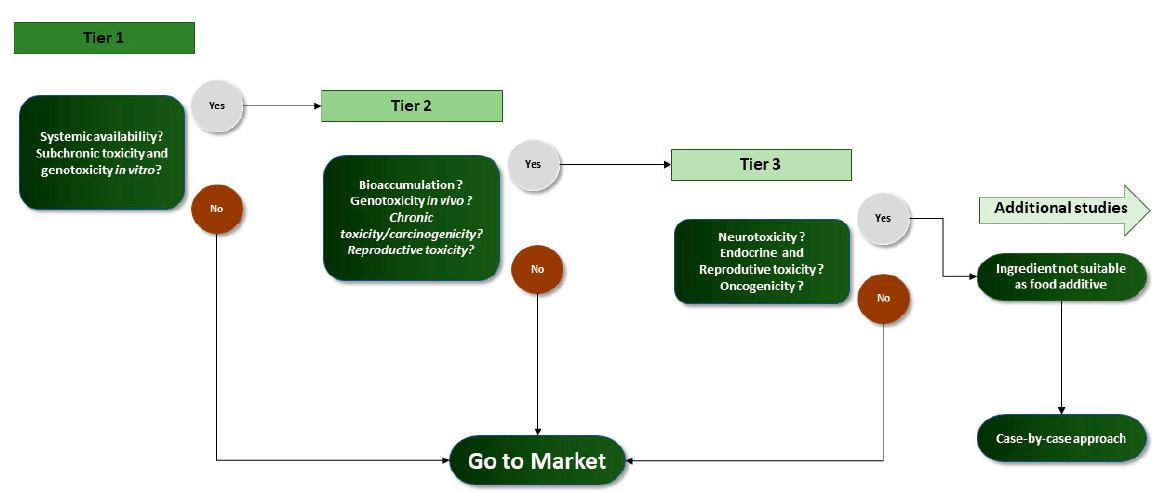
Figure 2. Triggers for the next tier in EFSA approach.